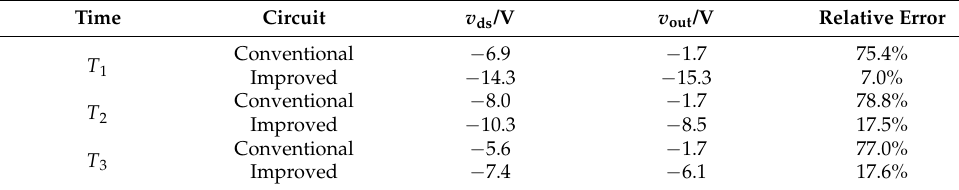
Table 3. Comparison of v ds and v out during the on-oscillation state.